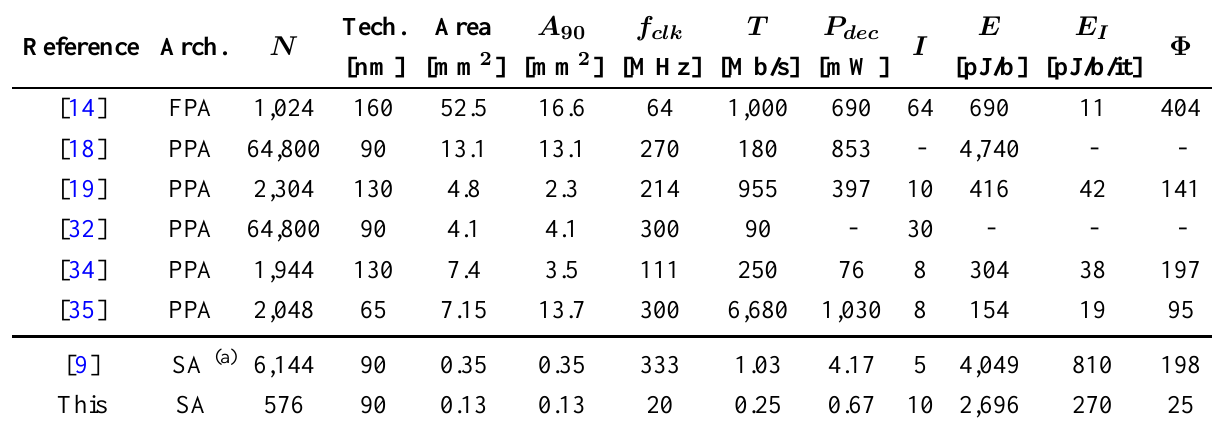
Table 2. Comparison of different